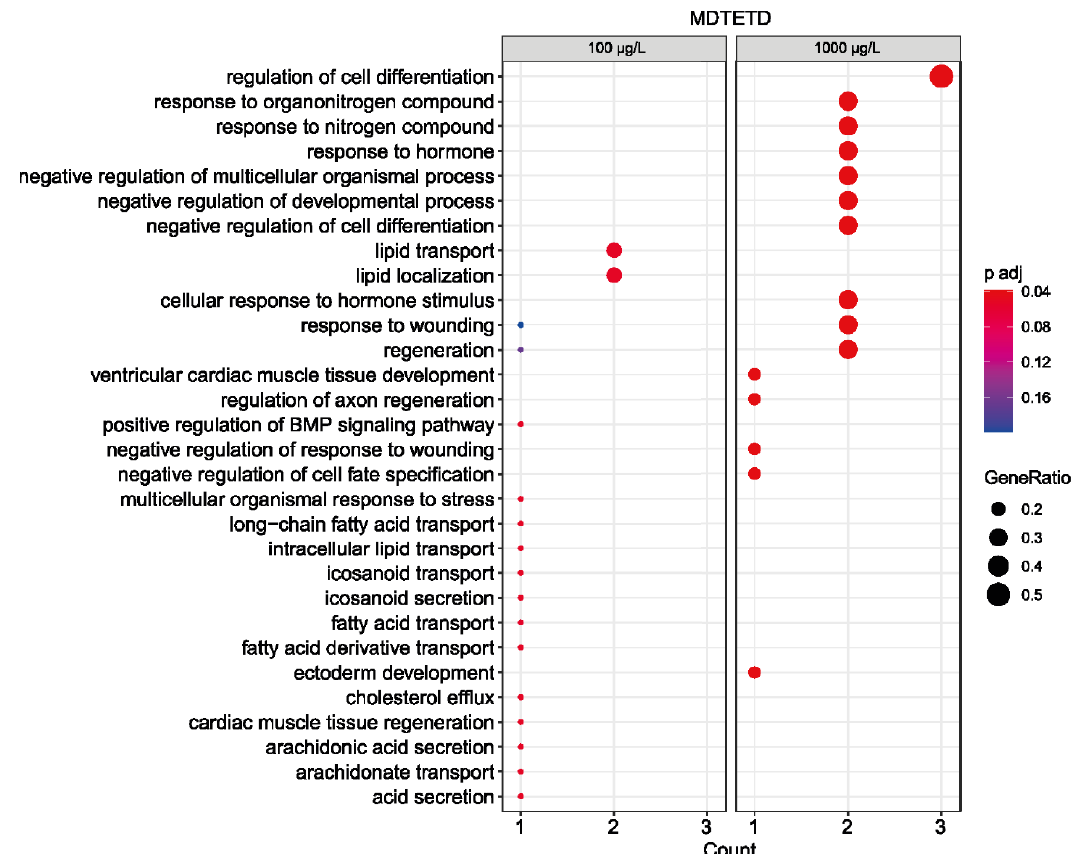
Figure 7. Overrepresentation analysis of GO biological processes based on statistically differentially expressed genes (padj ≤ 0.05) in zebrafish embryos after exposure to nominal concentrations of 100 µg/L (left panel) and 1000 µg/L MDTETD (right panel). The adjusted p -value is indicated as a color code, and the ratio of differentially expressed genes in each condition to the total number of genes assigned to each biological process is indicated by the dot size. The number of statistically differentially expressed genes assigned to each biological process for each condition is shown below.